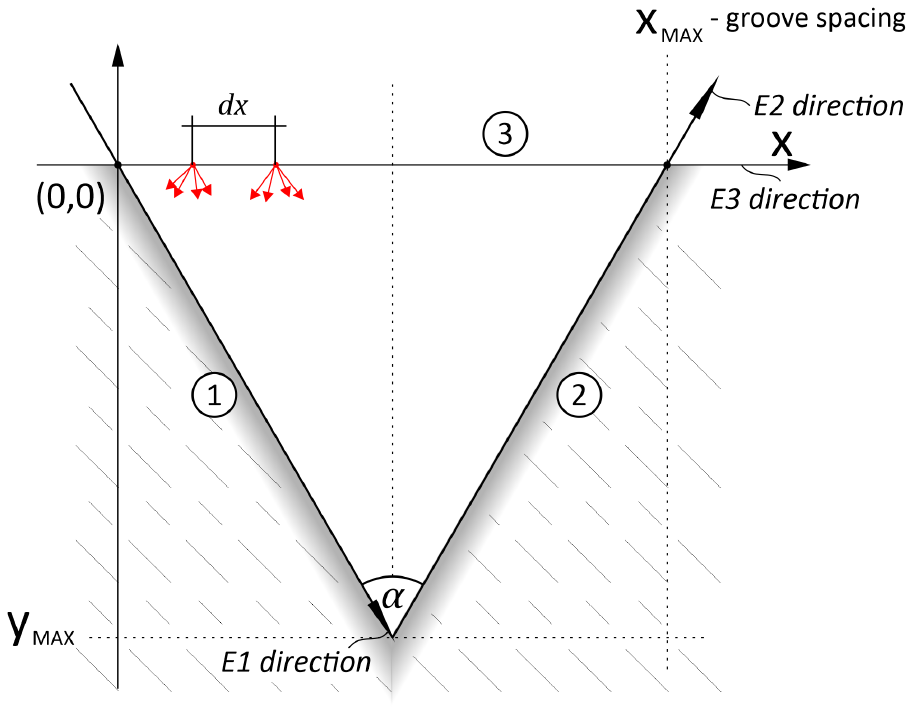
Figure 2. Model of the groove used for modeling. 1, 2 reflecting planes, 3—entry/escape